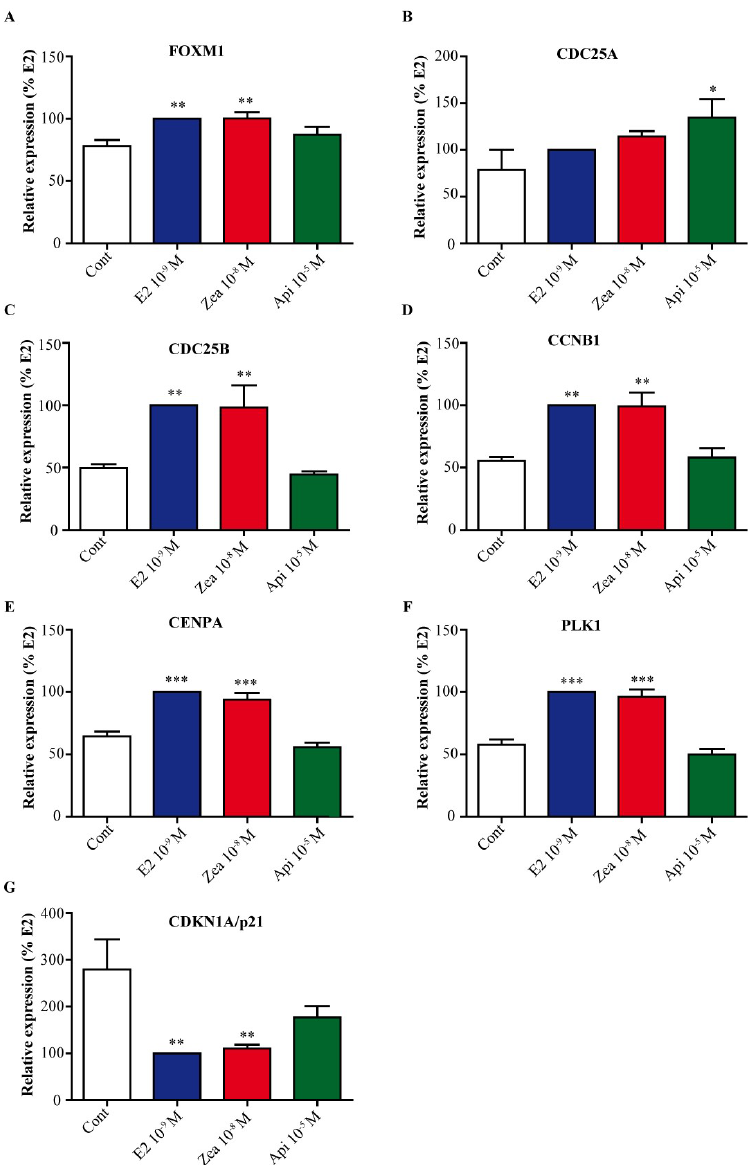
Figure 7. Validation of cell cycle-associated genes linked to forkhead box M1 (FOXM1). MCF-7 cells were treated with solvent (white) as a negative control, 10 −9 M E2 (blue) as a positive control, 10 −8 M zearalenone (red) or 10 −5 M apigenin (green) for 24 h. The expression of FOXM1 ( A ), cell division cycle 25A (CDC25A) ( B ), cell division cycle 25B (CDC25B) ( C ), cyclin B1 (CCNB1) ( D ), centromere protein A (CENPA) ( E ), polo like kinase 1 (PLK1) ( F ) and cyclin dependent kinase inhibitor 1A (CDKN1A/p21) ( G ) was assessed by real-time PCR. The expression level of each gene was normalized to the expression levels of the housekeeping genes glyceraldehyde-3-phosphate dehydrogenase (GAPDH) and TATA box binding protein (TBP). The results are expressed as the percentage of relative expression of transcripts obtained in E2-treated cells and are the means ± SEM of six independent experiments. * indicates a p -value < 0.05, ** indicates a p -value < 0.01 and *** indicates a p -value < 0.001 by one-way ANOVA followed by Dunnett’s post hoc test for comparison of the control treatment with the other treatments.